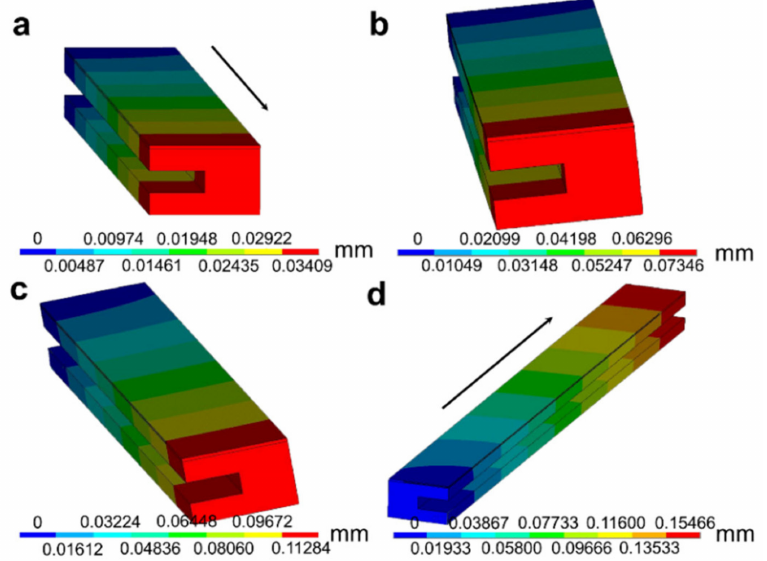
Figure 5. Thermal deformation distribution of the nitrogen–oxygen sensors under different heating temperatures: ( a ) 200; ( b ) 400; ( c ) 600; ( d ) 800 ◦